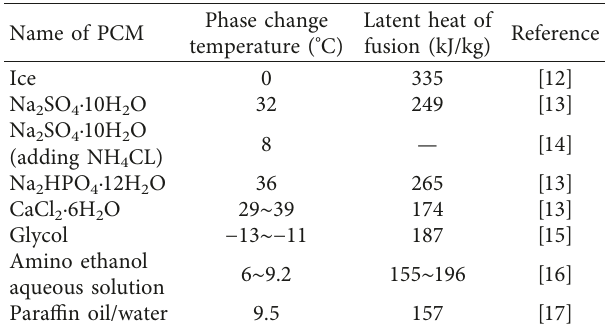
Figure 1: Cooling period of CLS backfill applied in upward sublevel filling method. (a) Preliminary period, (b) interim period, and (c) final period. Table 1: Conventional cold storage